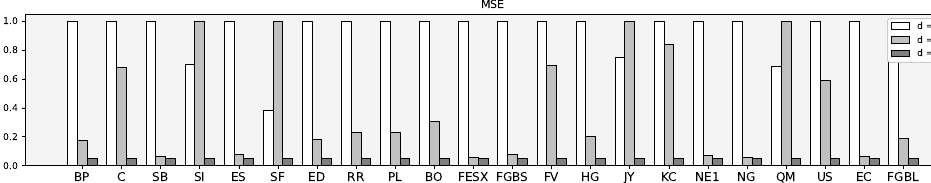
Figure 9. MSE scaled between 0 and